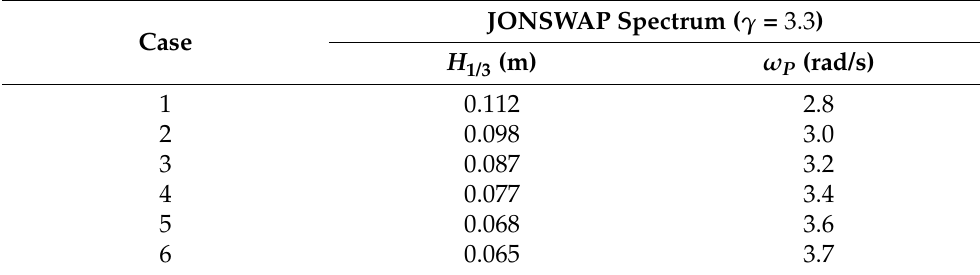
Table 8. Irregular wave